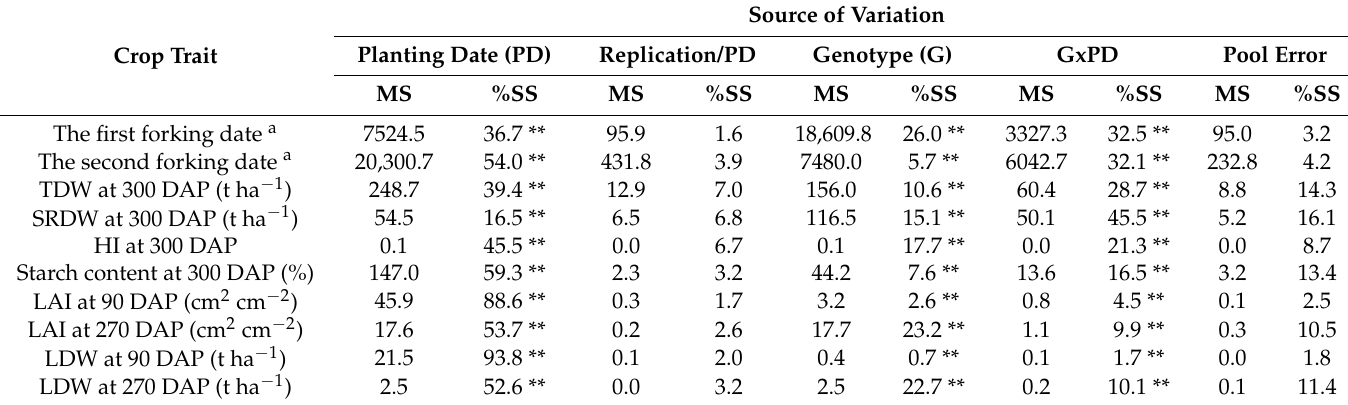
Table 2. Mean squares (MS) and percentage of sum squares (%SS) from the combined analysis of the physiological traits for four cassava genotypes grown on eight planting